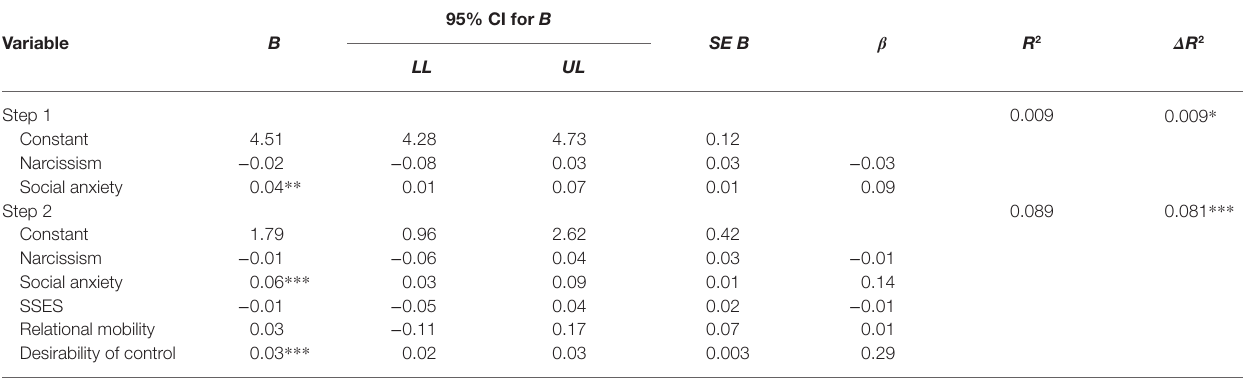
TABLE 3 | Hierarchical regression results for attitudes toward singlehood (single individual, n = 870).